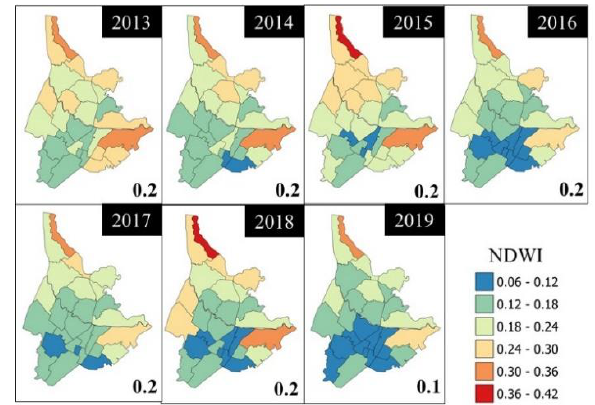
Figure 7. Barangay-level average NDWI maps of Mandaue